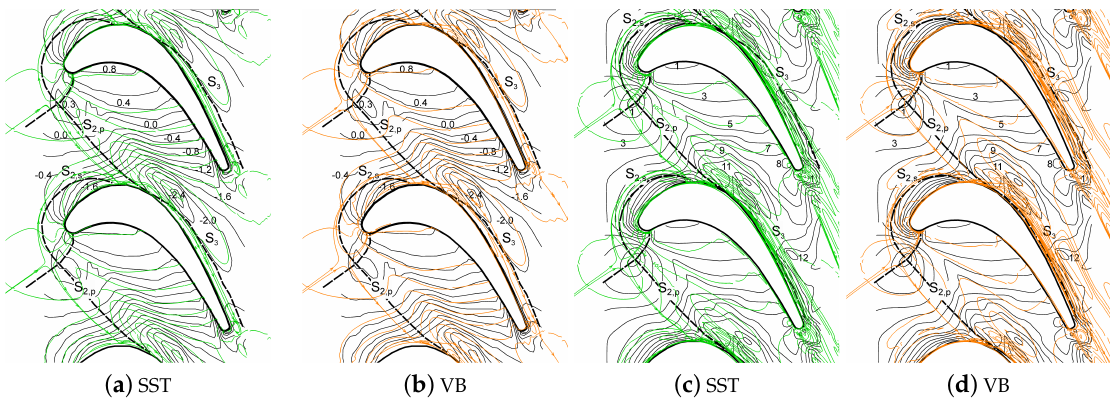
Figure 4. Comparison between experimental [19] and numerical results for surface pressure coefficient c p as well as skin friction coefficient c f × 10 3 isolines on the sidewall of the Langston